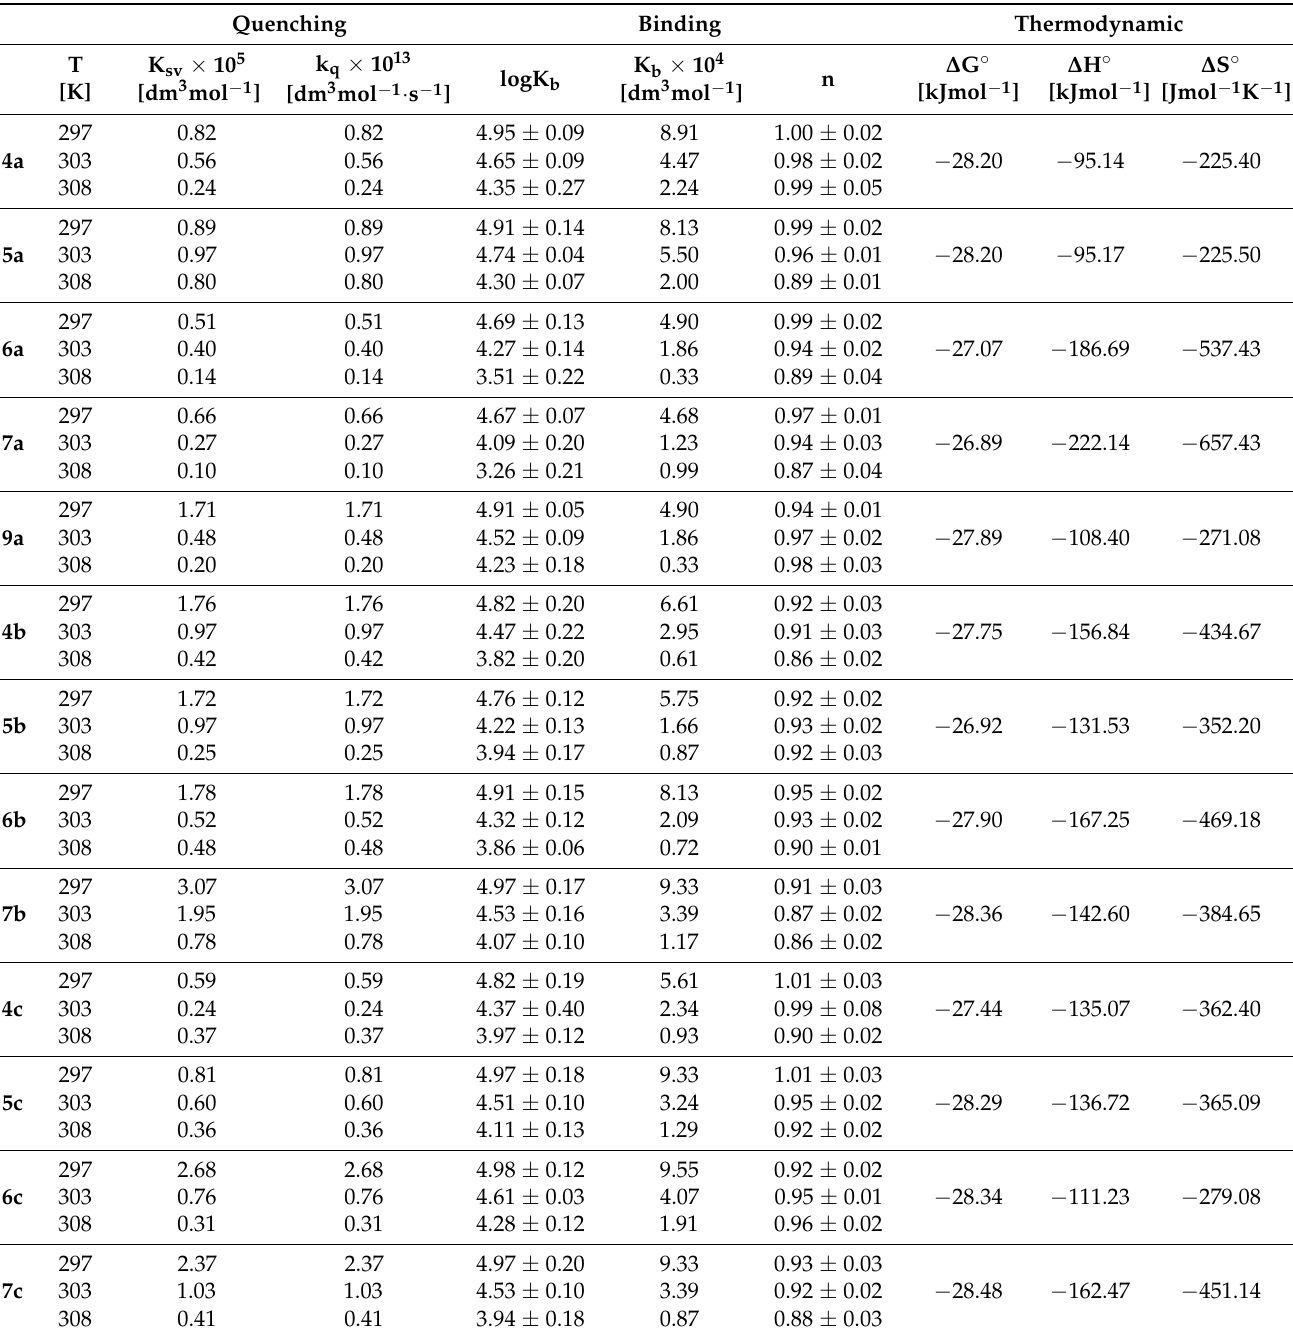
Table 4. The Stern–Volmer constant K sv and the quenching rate constant k q , the binding constants K b and number of binding sites n and the thermodynamic parameters for the interaction of BSA with studied compounds at different temperatures. Quenching Binding Thermodynamic